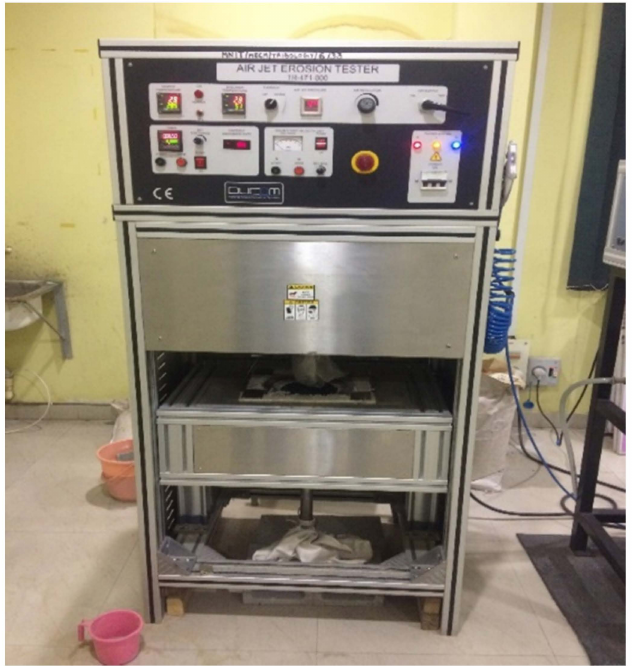
Figure 5. Air jet erosion test machine set